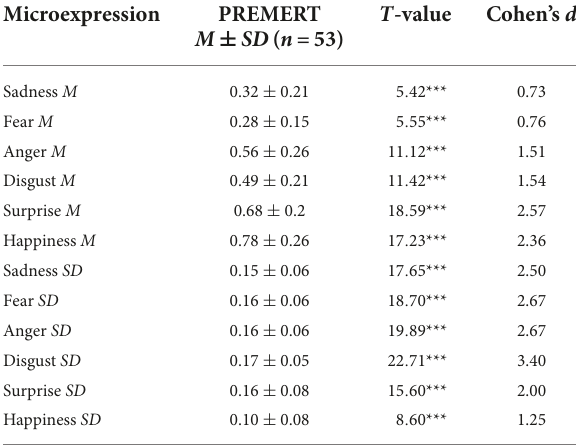
TABLE 2 The exploratory factor analysis of microexpression recognition